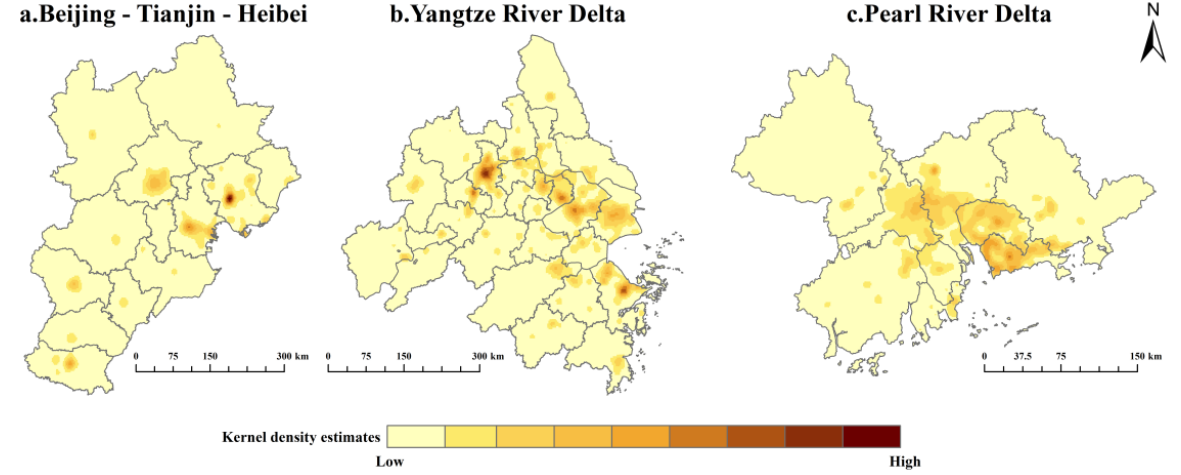
Figure 5. Kernel density estimation maps of CO 2 emissions of three urban agglomerations in 2019.